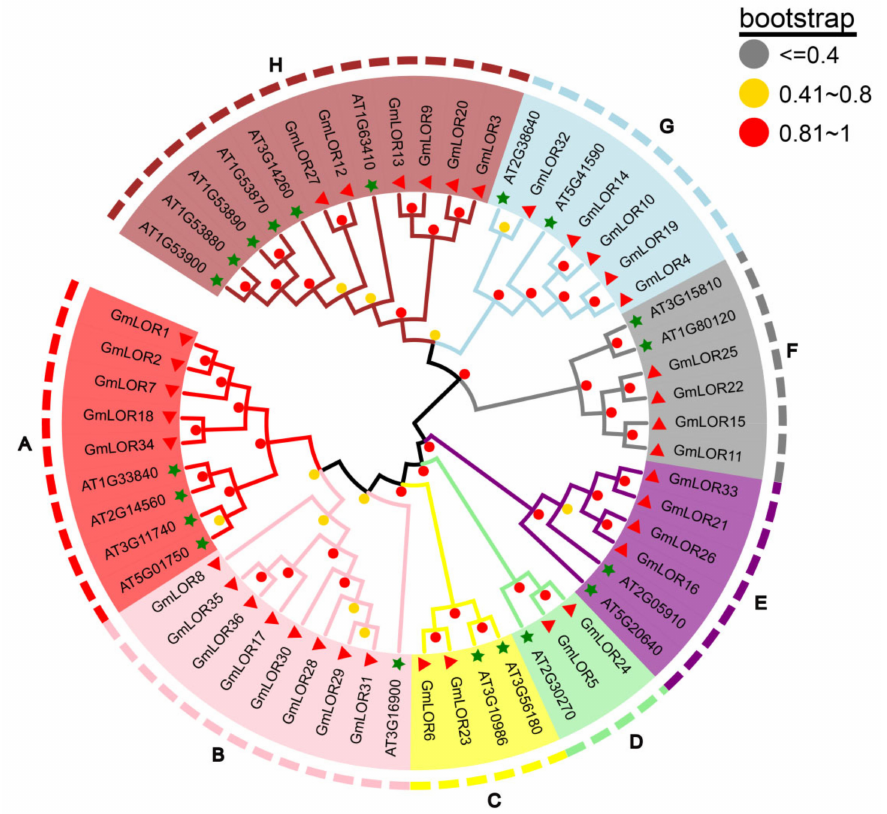
Figure 1. Phylogenetic analysis of soybean and Arabidopsis LOR proteins. The tree was conducted based on the full-length amino acid sequences using MEGA 6.0 by the neighbor-joining method with 1000 bootstrap replicates. Bootstrap values are shown in different-colored solid circles on the branches. Bootstrap values (1000 repetitions) less than 0.41 are represented by gray solid circles, those between 0.41 and 0.8 are represented by yellow solid circles, and those above 0.81 are represented by red solid circles in the corresponding branches. The green five-pointed star represents AtLOR family members. The red triangle represents GmLOR family members. The tree shows eight major phylogenetic subgroups (A to H) indicated with different colored